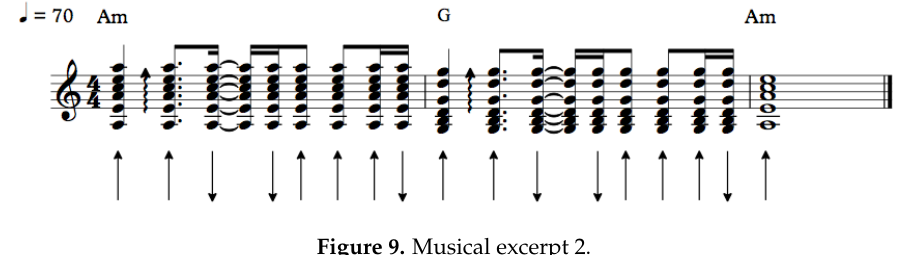
Figure 9. Musical excerpt 2.